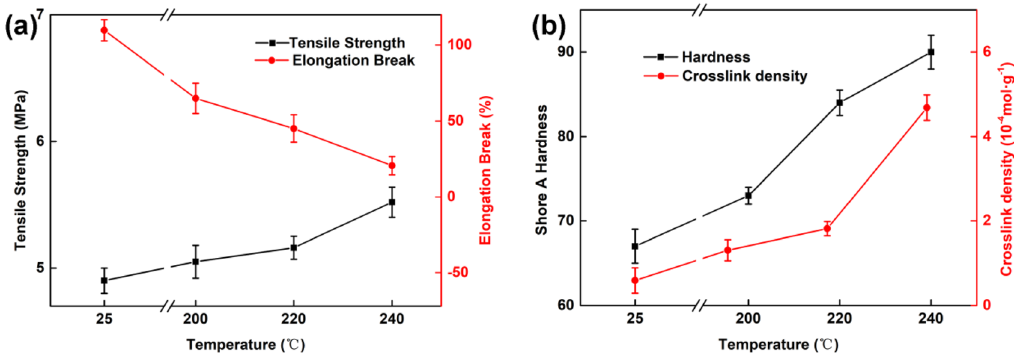
Figure 1. The tensile strength and elongation at break ( a ) and hardness and crosslink density ( b ) of the composites under different ageing